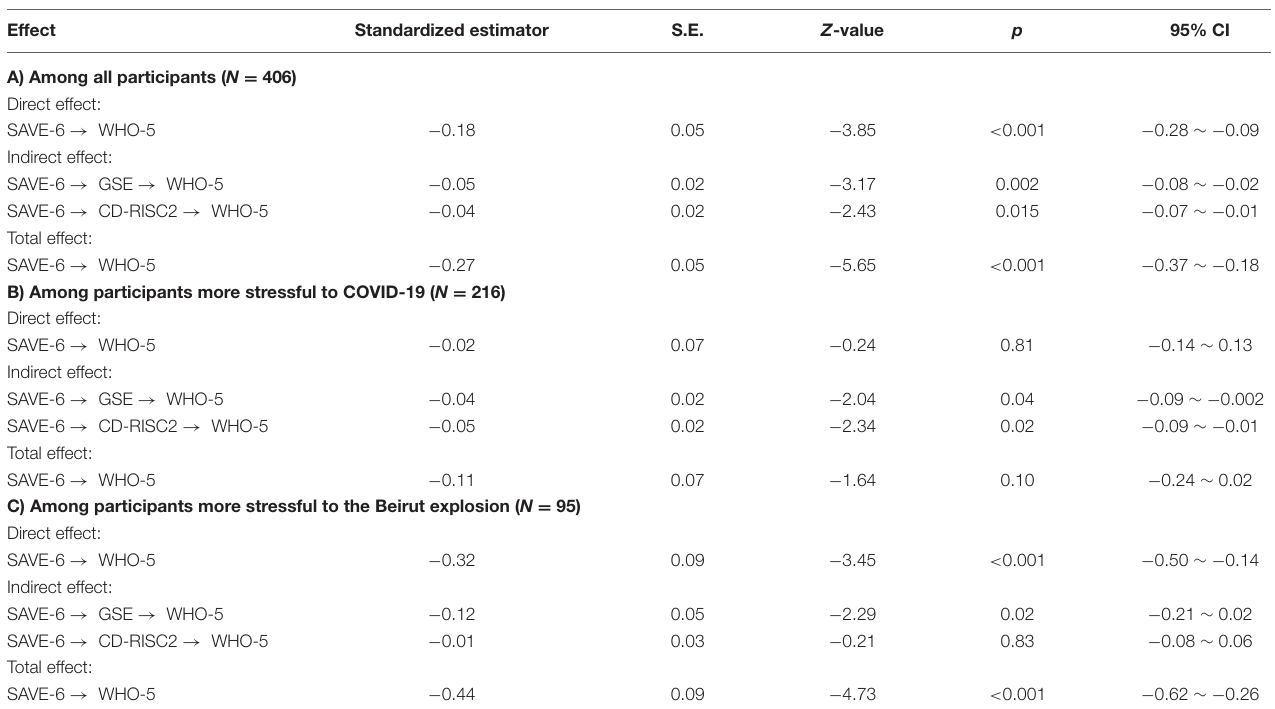
TABLE 5 | The mediation effect of resilience or self-efficacy on the relationship between viral anxiety and psychological well-being. Effect Standardized estimator S.E. Z -value p 95%